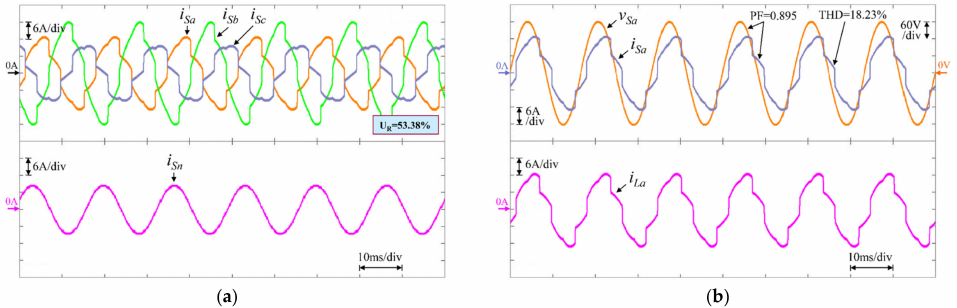
Figure 5. Experimental results without using DSTATCOM at RL2. ( a ) Response of grid currents and neural current; ( b ) Response of phase- a grid voltage, phase- a grid current, and phase- a load